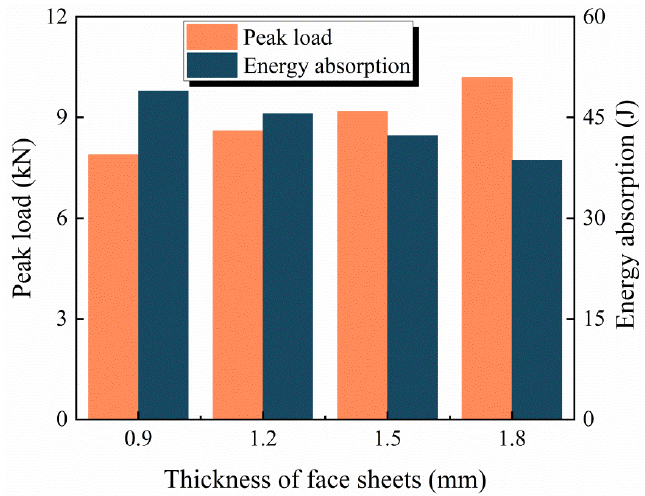
Figure 12. Peak load and impact energy absorption with different face sheet